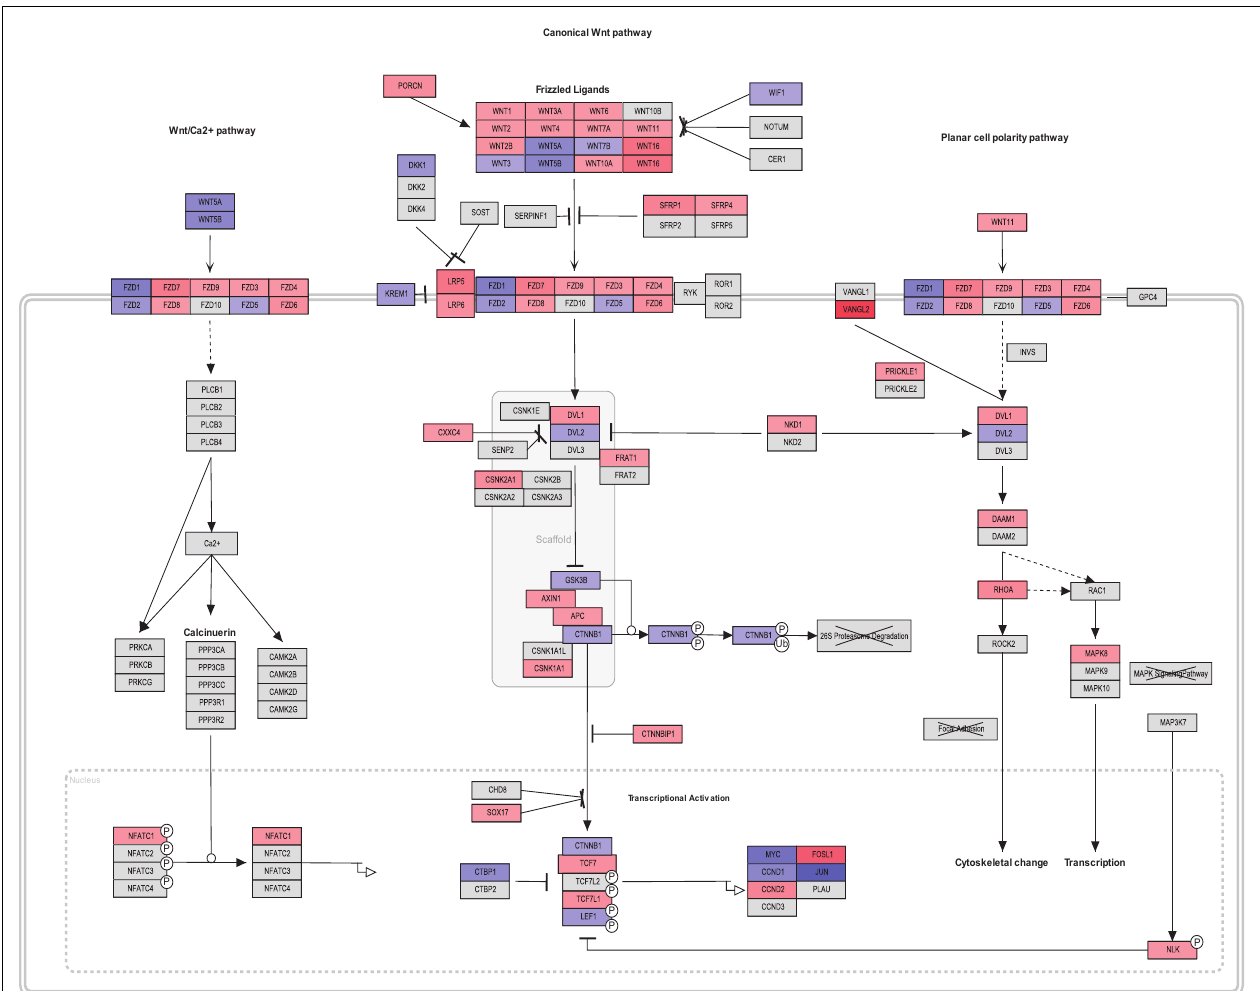
FIGURE 7 | Wnt signaling gene expression profiling in healthy versus asthmatic bronchial fibroblasts generated by PathViso pathway analysis and drawing software. The coloring scheme depends on the log fold change of asthmatic fibroblast expression versus healthy controls fibroblasts where red indicates that the gene is upregulated in asthma and blue means it is downregulated in asthma compared to